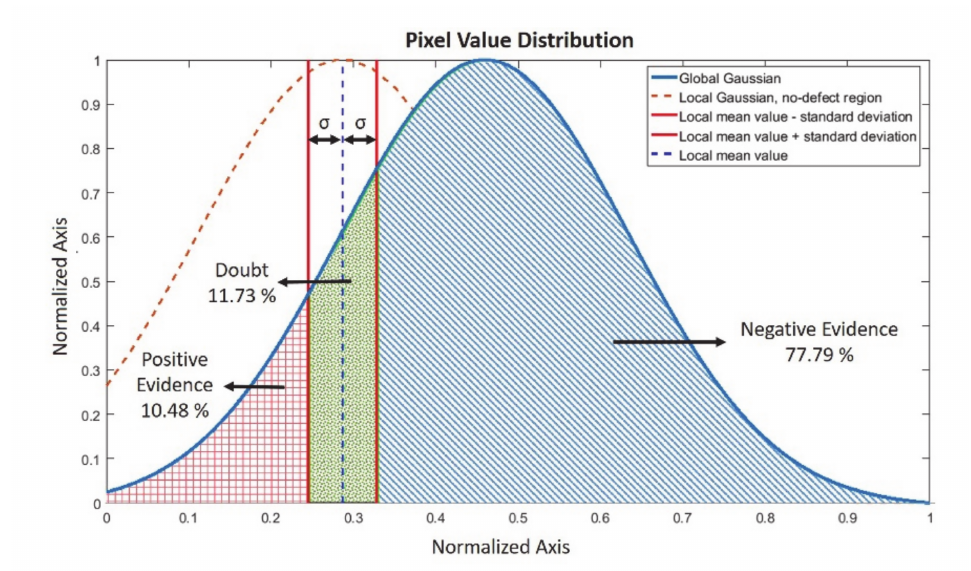
Figure 8. Schematic representation of D-S belief probability calculations for a random point using its local neighbourhood on the defect-free region on the global distribution of feature matrix (Positive evidence is where there is a defect, negative evidence is where it is non-defective, and doubt is where theere is a high plausibility.)